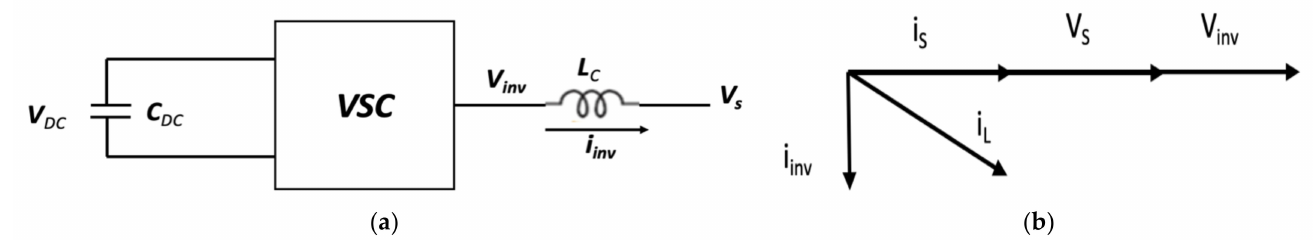
Figure 3. Active power filter (HAPF) architecture: ( a ) reactive power flow; ( b ) vector